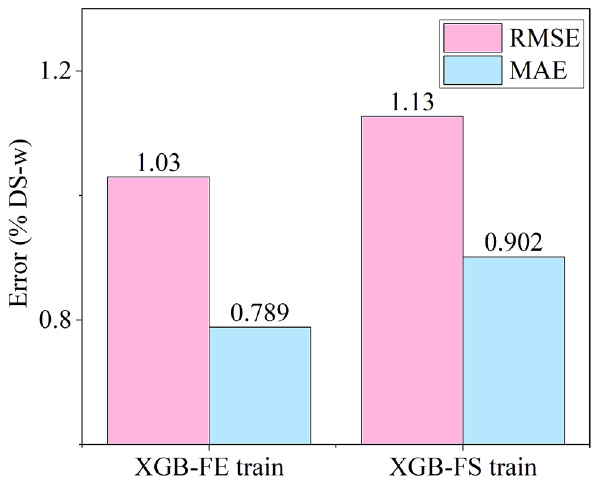
Figure 10. Leave-one-out cross-validation (LOOCV) scores for XGB-FS and XGB-FE machine learning models for the training set with fixed random split seed ‘random_state = 2’. Note y-axis was truncated for convenience.